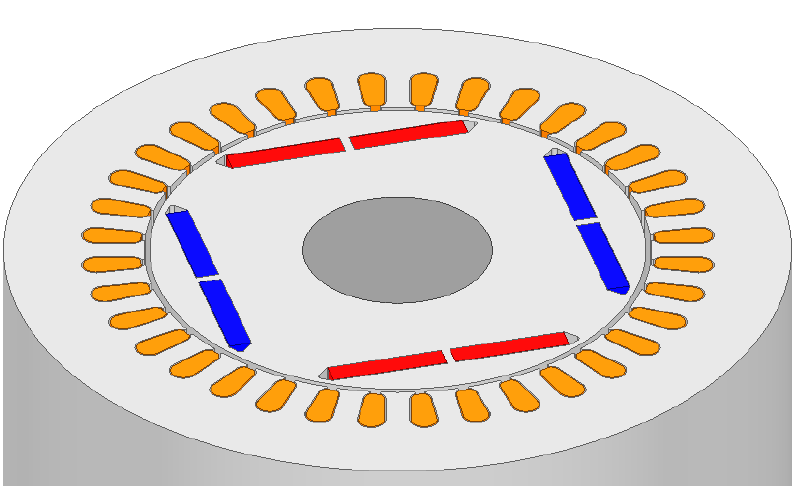
Figure 10. Reference model without the stator end-windings. Table 2. Summary of the values of the components of C wr(ref) capacitance: C wr(slot_ref) and C wr(ew_ref) .